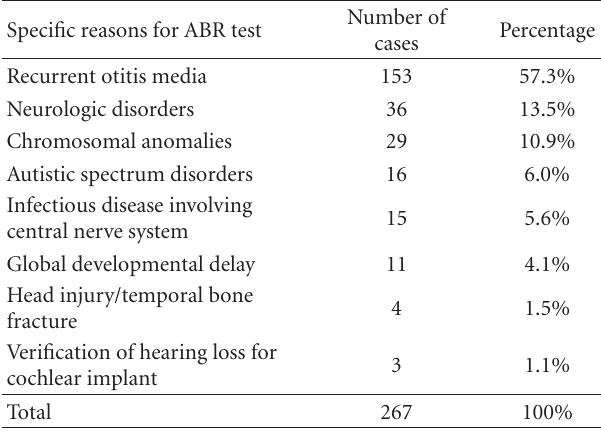
Table 1: A summary of specific reasons for ABR testing in the operating room, with the number of cases in each category